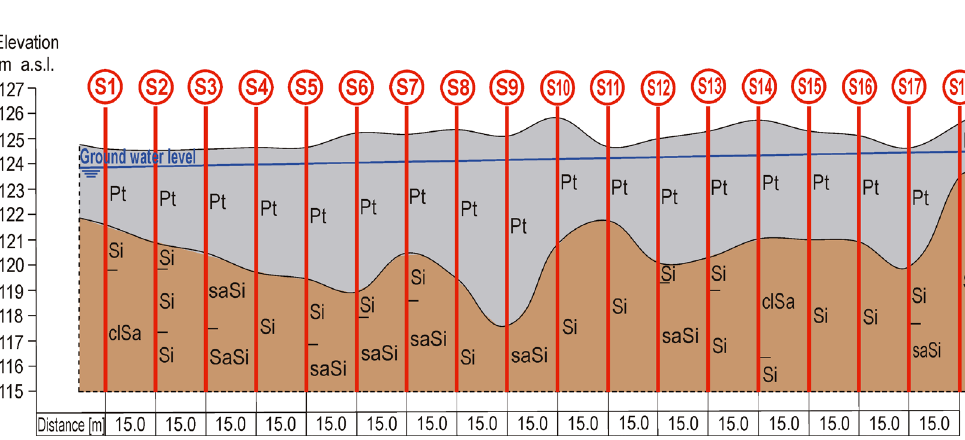
Figure 1. Geotechnical cross-section and piezocone penetration tests